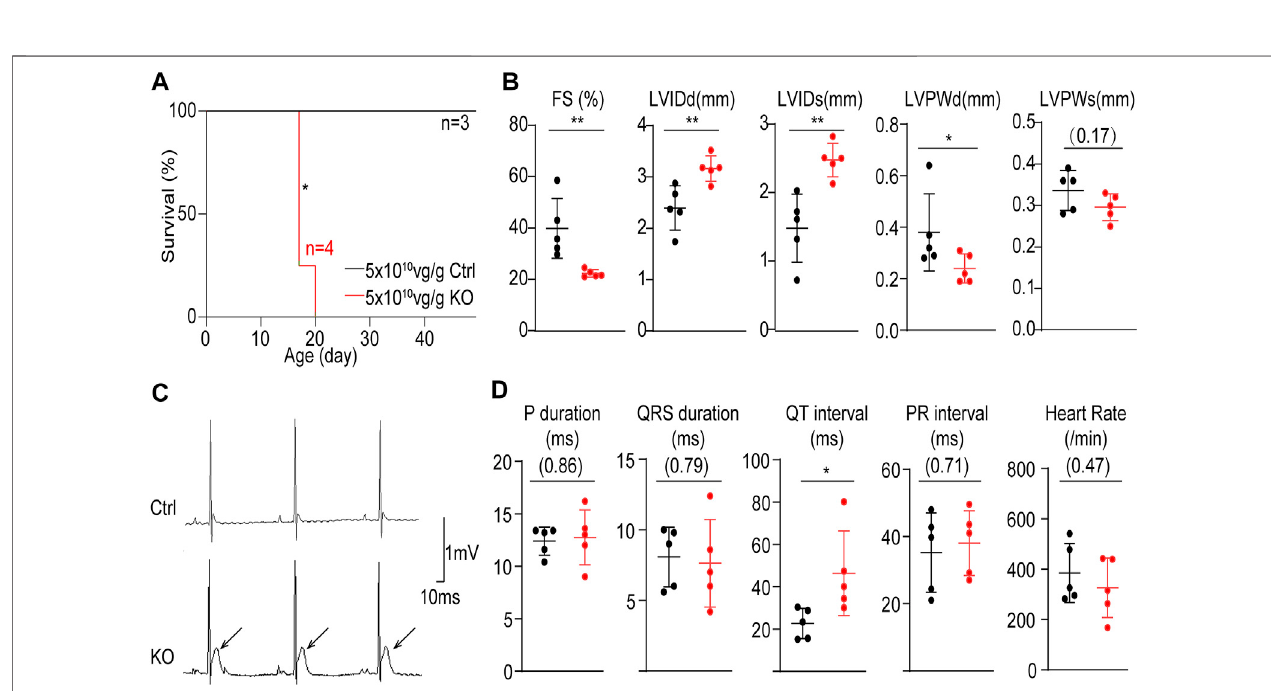
FIGURE 3 | The impact of whole-heart cardiomyocyte-speci fi c Atp2a2 knockout on cardiac functions. (A) , Survival analysis of animals treated with high-dose control (Ctrl) and Atp2a2 knockout (KO) AAVs. Log-rank test, * p < 0.05. (B) , Quanti fi cation in echocardiogram analysis. FS, fractional shortening; LVIDd, left ventricular internal diameter end diastole; LVIDs, left ventricular internal diameter end systole; LVPWd, left ventricular posterior wall end diastole; LVPWs, left ventricular systolic posterior wall end systole. (C) , Representative electrocardiogram traces. Arrows point to elevated ST segments. (D) , Quanti fi cation in electrocardiogram analysis. In C and D , mean ± SD (horizontal lines) and individual data points (dots) were presented. Unpaired two-tailed student ’ s t-test: * p < 0.05, ** p < 0.01, non-signi fi cant p values in parenthesis.